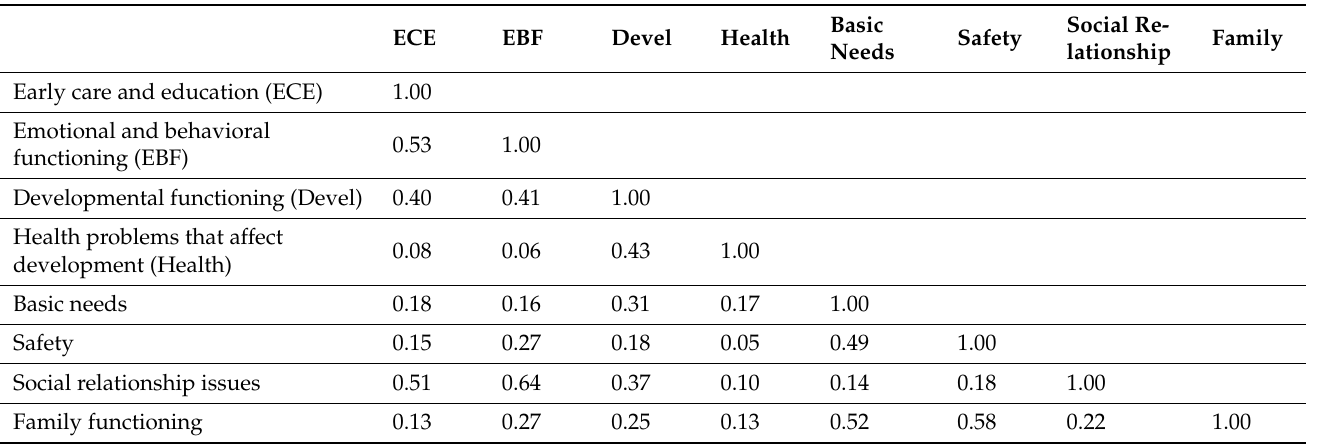
Table A1. Correlation table between latent constructs of interest ( n = 448 unique individuals in the dataset).